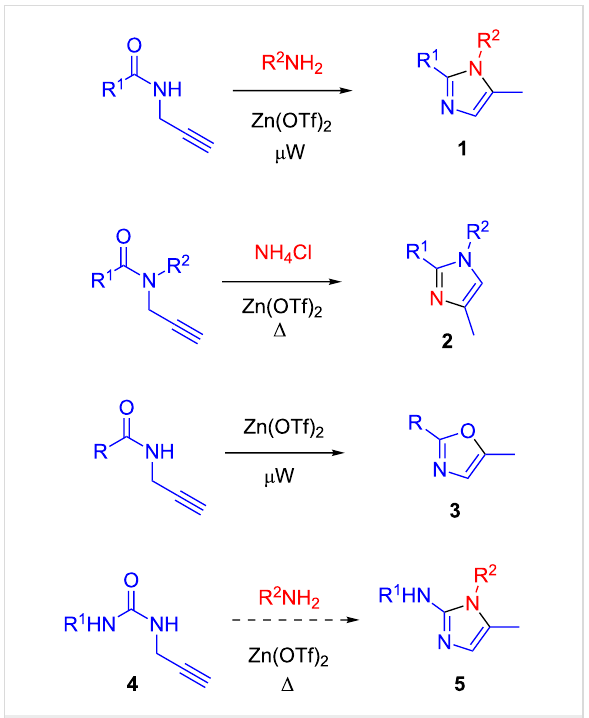
Figure 1: Examples of imidazole ( 1 and 2 ) and oxazole ( 3 ) syntheses from propargylamides previously reported and the reaction of propar- gylureas 4 with primary amines studied in this